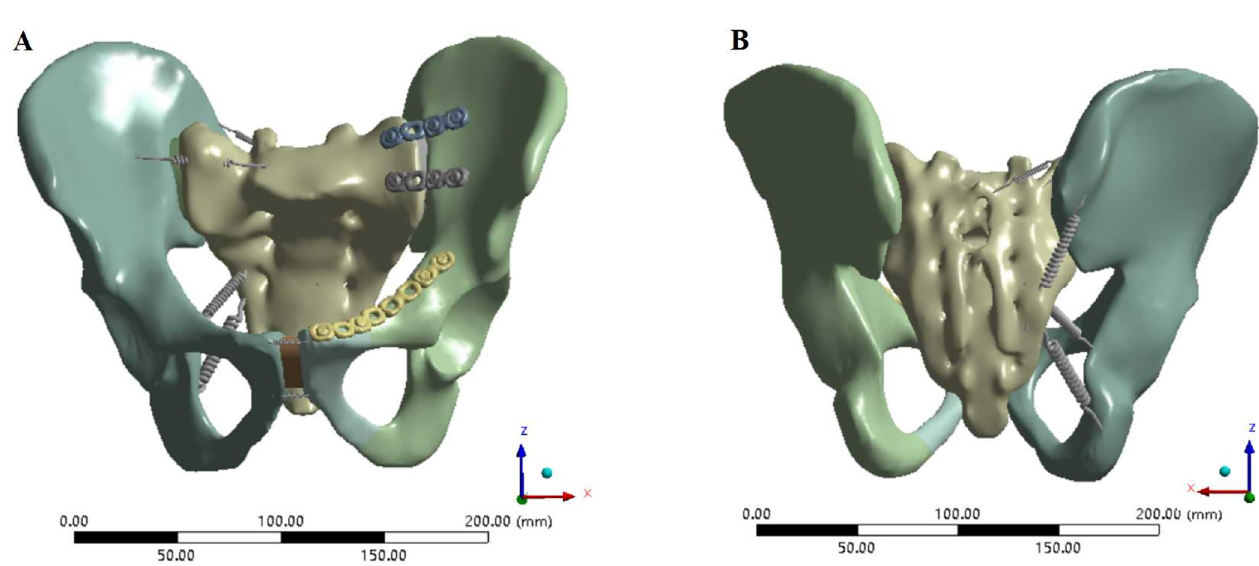
Fig 2. FE model of anterior reconstruction plate fixation for the treatment of Tile C1 pelvic fractures. (A) Anterior view of the FE model fixed by the reconstruction steel plate. (B) Posterior view of the FE model fixed by the reconstruction steel plate.